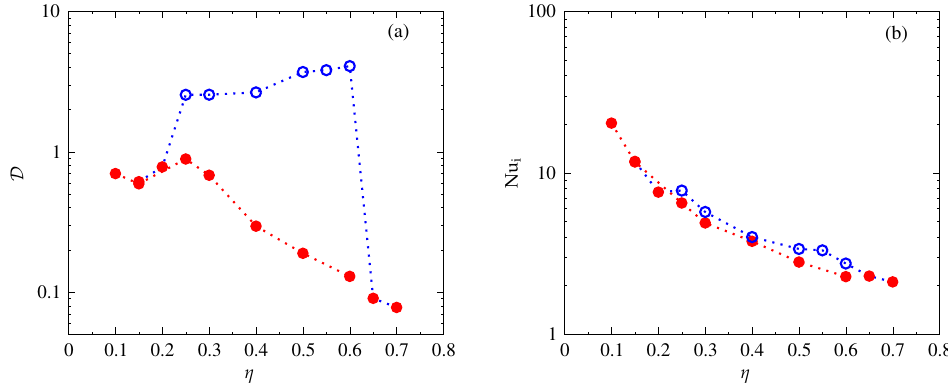
= D 10 4 , P = 0.75 and R c , τ = 2 × ×